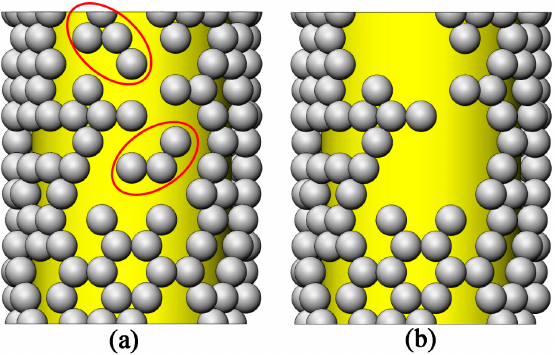
Figure 2. The schematic diagram of the case in which the shell is smaller than one layer, ( a ) the particles are randomly dispersed on the fiber face and some particles do not percolate in the red oval frame and ( b ) shows the schematic after deleting the particles that do not percolate.